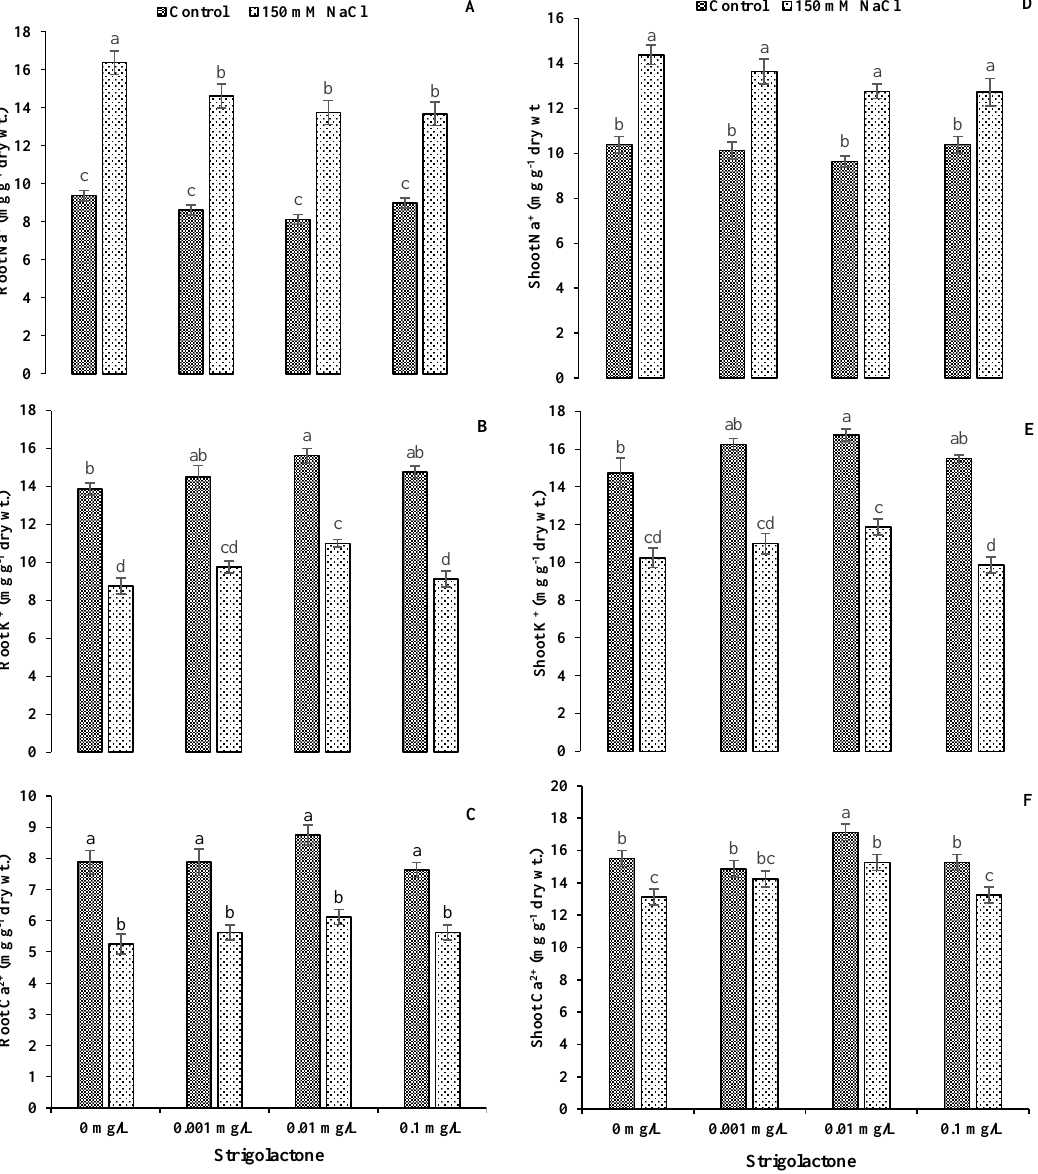
Figure 6. Impact of GR24 on root Na + ( A ), K + ( B ) and Ca 2+ ( C ) and shoot ( D ), K + ( E ) and Ca 2+ ( F ) ions of ornamental sunflower under control and salt stress conditions. Each vertical bar shows the mean of three replicates. Different letters indicate significant differences among treatments at p ≤ 0.01 according to least significant difference test.